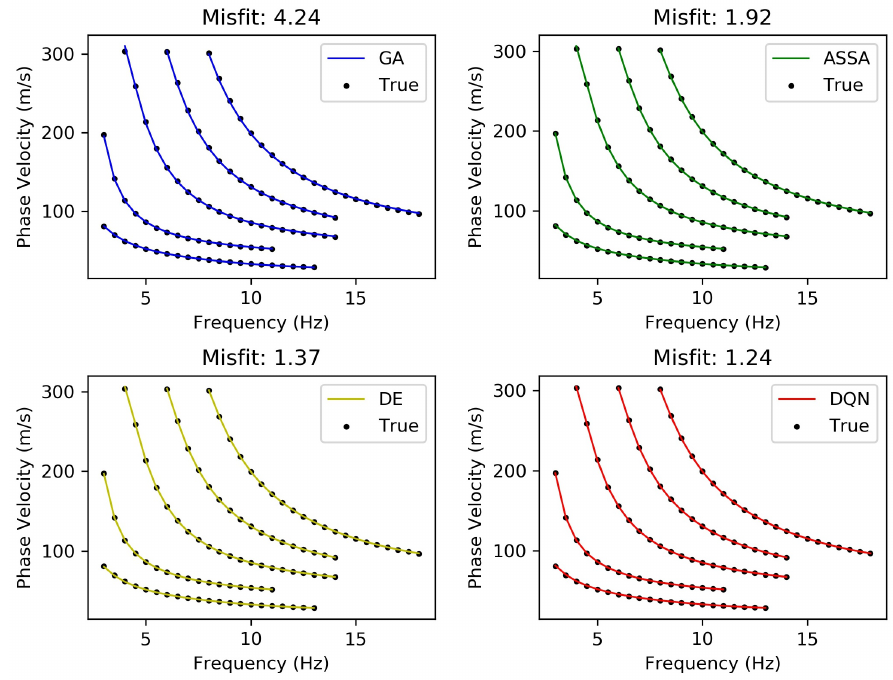
Figure 7. The estimated dispersion curves with the ground truth in Case